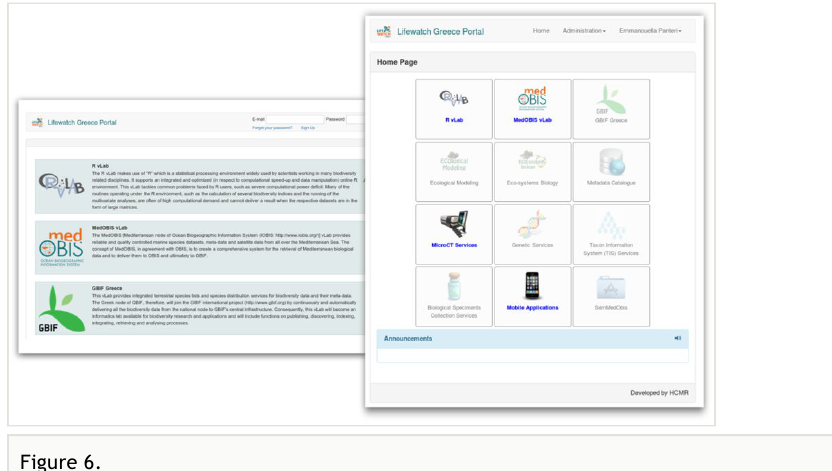
Screenshot of portal's landing (left image) and home page (right image) available via the LifeWatchGreece portal, displaying basic information on all virtual laboratories (including